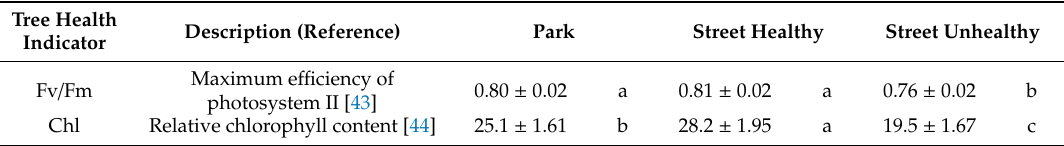
Table 1. Chlorophyll fluorescence and foliar chlorophyll (Chl) content used to estimate tree health. Fv = variable fluorescence, Fm = maximum